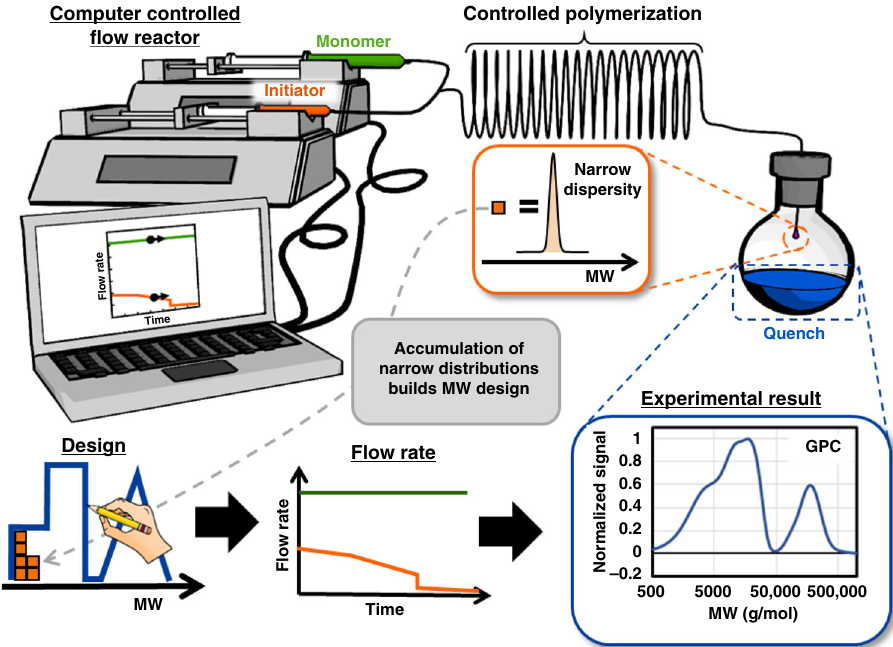
Fig. 2 Overview of the fl ow reactor setup and methodology for MWD control. The computer-controlled fl ow reactor generates narrowly dispersed polymer samples which accumulate in the collection vessel to build the target MWD. Reprinted (adapted) with permission from Macromolecules 2019, 52, 13, 4847 – 4857. Copyright (2019) American Chemical